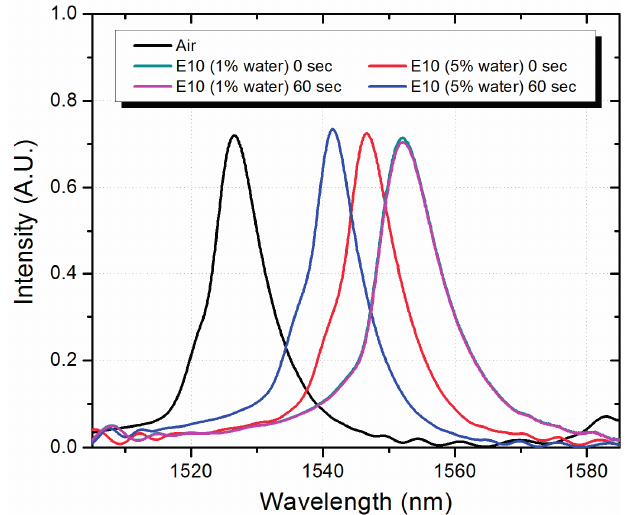
Figure 7. Spectral response of the MMI sensor for E10 gasohol with different water concentrations (1% and 5%) acquired right after shaking (0 s) and when the gasohol has been settled during 60